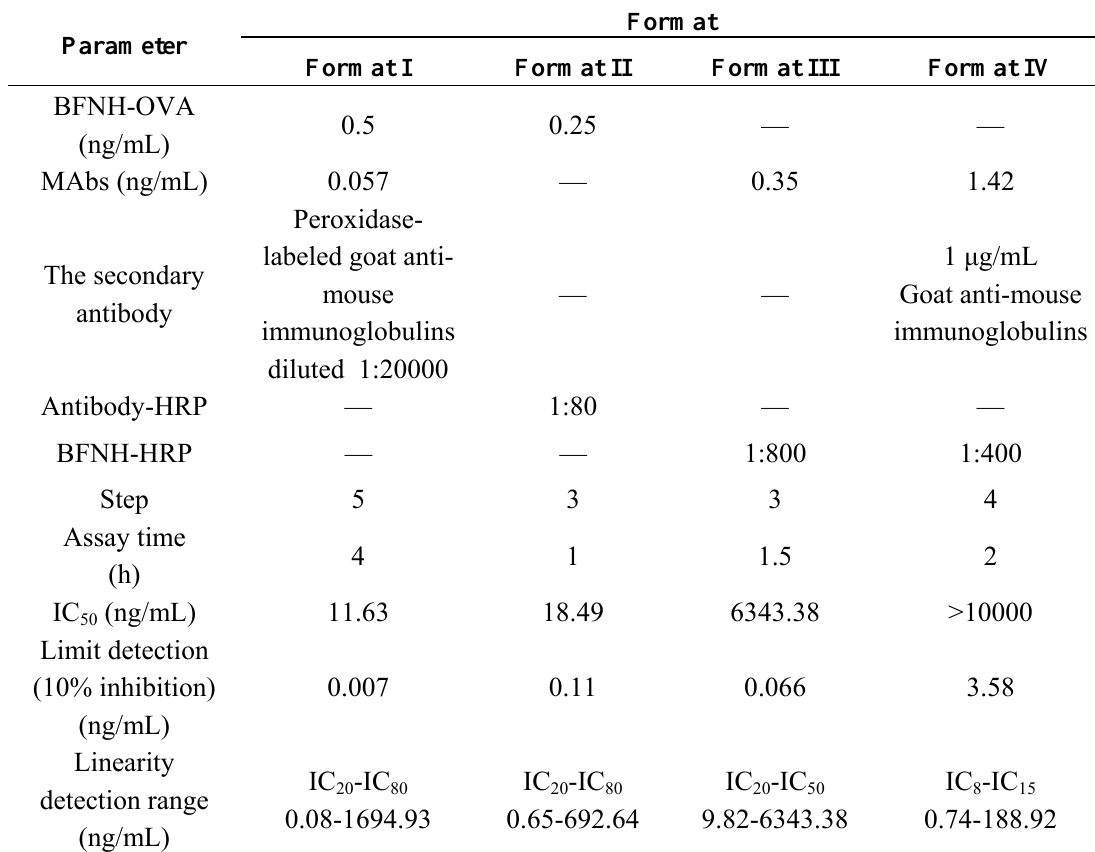
Table 1 . A summary of the four carbofuran